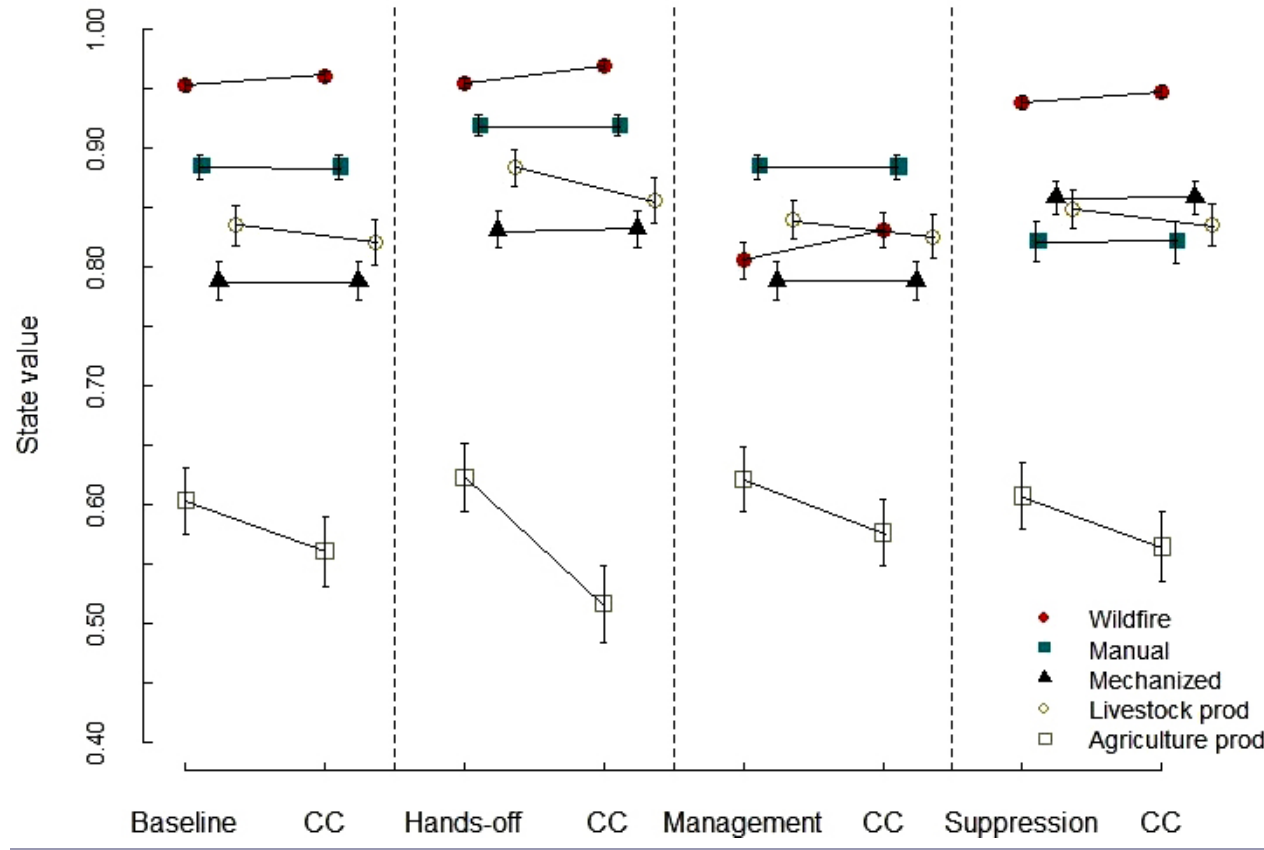
Fig. 6 . Scenario outcomes for selected variables in the augmented fuzzy cognitive map (FCM), including the effect of more prolonged dry periods for each scenario (noted as climate change, CC). Point symbols show state value of selected variables after scenario runs. Error bars represent the uncertainty in the model outputs obtained for each scenario by varying all the edge weights in the FCM within 10% of their value. The baseline and scenario outputs are separated by vertical lines to ease